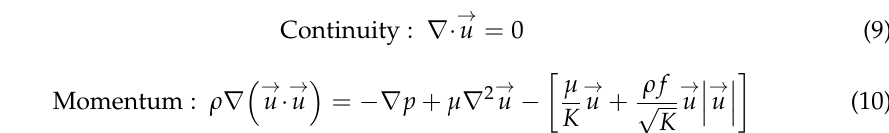
Figure 1. Solution domain for preliminary study.